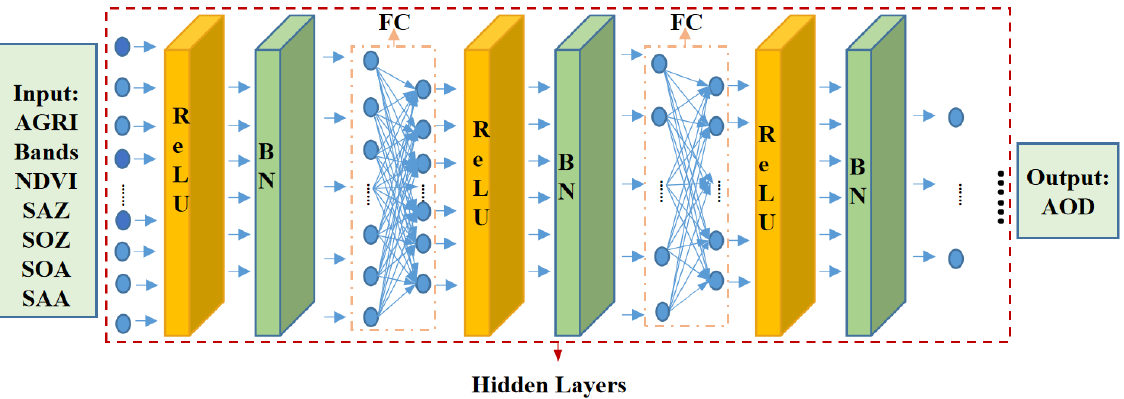
Figure 3. Architecture of the FCNN model for FY-4A/AGRI aerosol retrieval (input nodes: feature selection of AGRI bands (b1, b2, b3, b5, b6, b7, b8, b9, b10, b11, b13), SAZ, SOA, SAA, SOZ, and the NDVI; output node: AOD at 550 nm). Rectified linear unit (ReLU) is the activation layer. BN is a batch normalization layer and was adopted to perform the standardizing and normalizing operations on the input of a layer coming from a previous layer, by bringing the numerical data to a common scale. DP is the dropout layer, which was used to reduce overfitting by randomly and temporarily deleting neurons in the hidden layer during the training with a given probability. FC is the fully connected layer. The circles represent the input and output parameter of one layer, the arrows represent the transfer direction of FCNN.